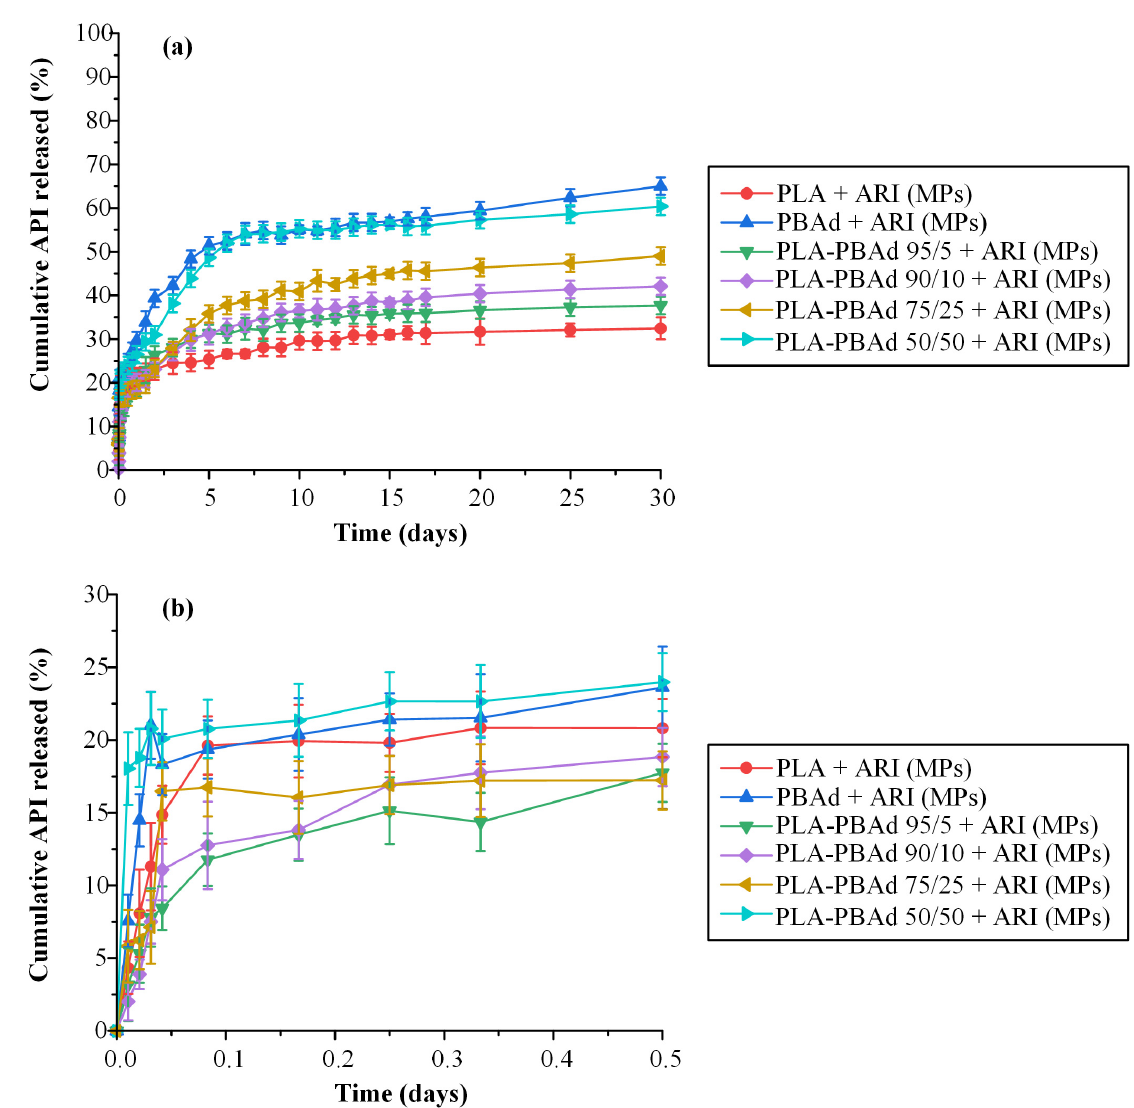
Figure 8. In vitro drug % release vs. time of the encapsulated ARI in PLA/PBAd MPs, during the 30 ( a ) and the 0.5 ( b ) days of the experiment. Table 4. % Aripiprazole drug remained in the MPs at the end of the in vitro release study.